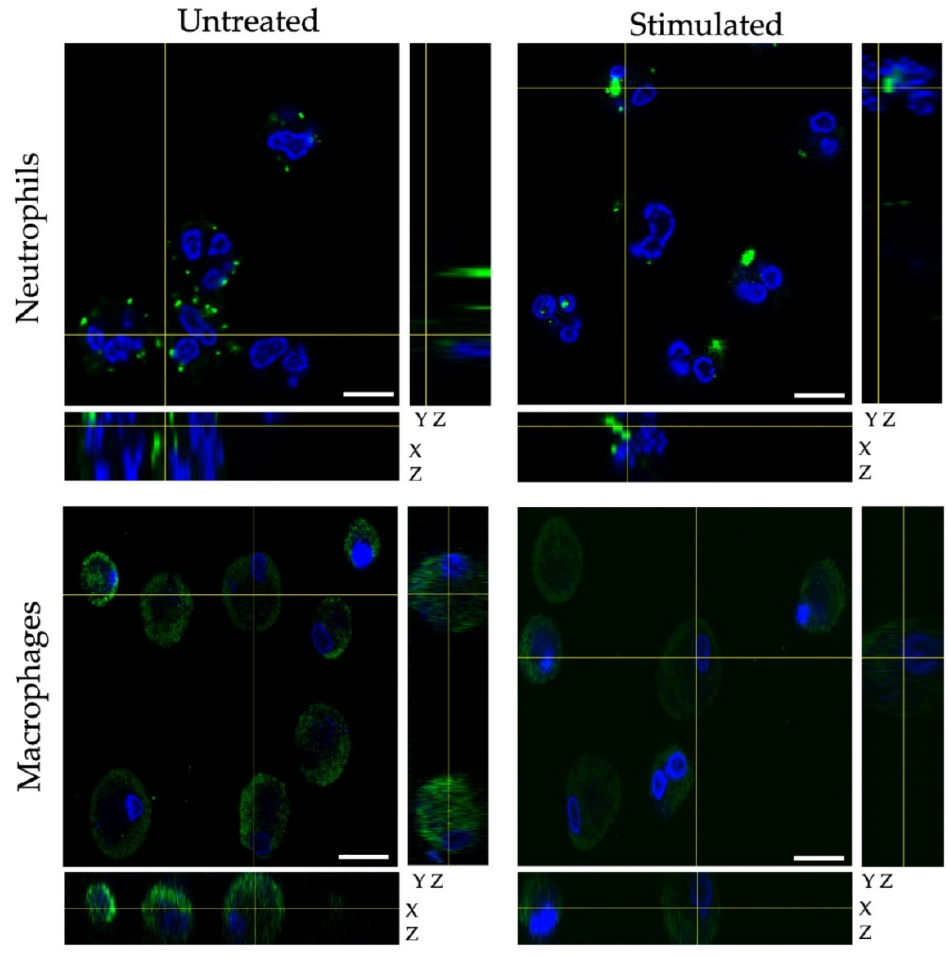
Figure 3. Z-stack confocal fluorescence microscopy images of neutrophils (untreated and PMA-stimulated), and macrophages (untreated and LPS-stimulated). Cells were incubated with compound 2a (10 μ M, λ exc = 488 nm, λ em = 550–680 nm) and counterstained with Hoechst 33342 for nuclear labelling. Scale bar: 15 μ m.